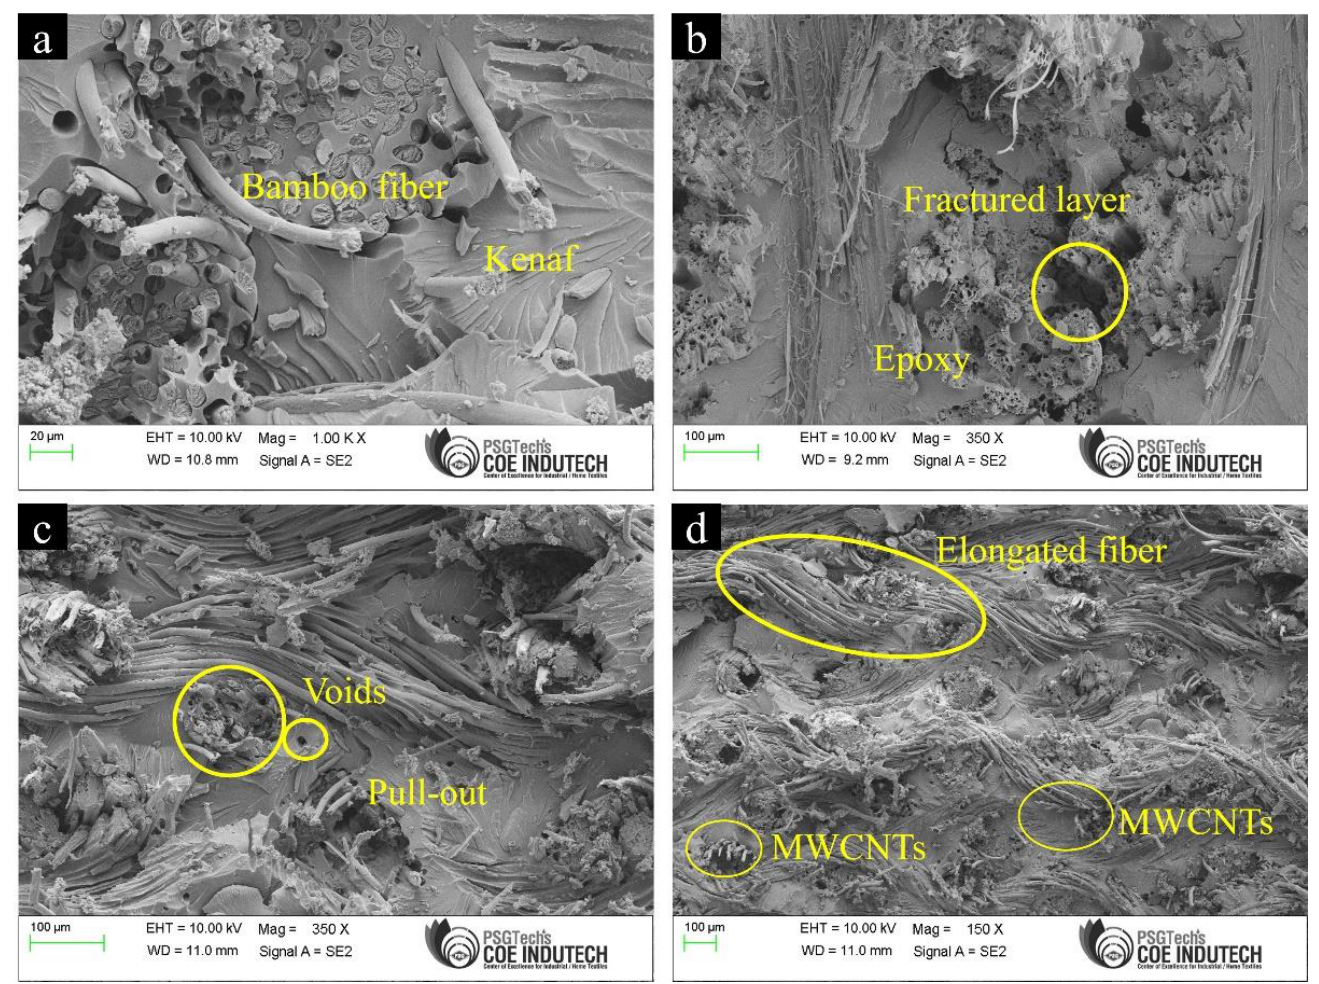
Figure 5. SEM images of the fracture surfaces from tensile testing of laminate 6 (Bamboo + Kenaf + Epoxy + MWCNT), showing ( a ) the reinforcement of Bamboo and Kenaf fibre in the Epoxy matrix; ( b ) the fractured layer from tensile testing; ( c ) fibre pull-out mechanism in the composite, and; ( d ) reinforcement with MWCNT and elongated fibre in the Epoxy matrix. Table 4. Summary of tensile properties reported in other studies and the present